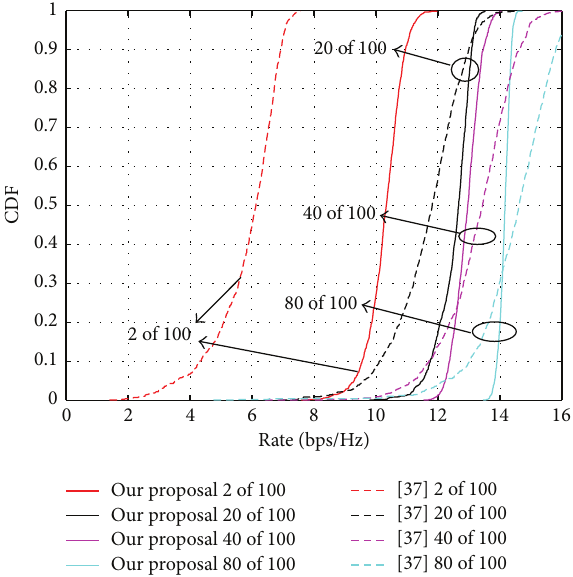
Figure 6: Comparison of CDF versus achievable rates of our proposal with exhaustive search method and [37].